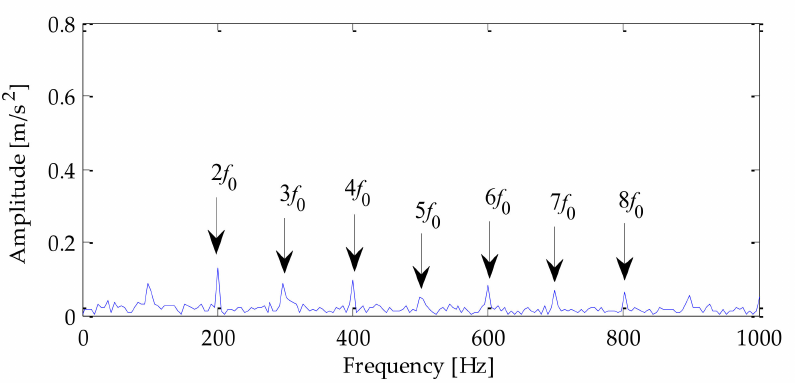
Figure 17. Analysis of signal envelope spectrum after noise reduction based on LMD–RobustICA.